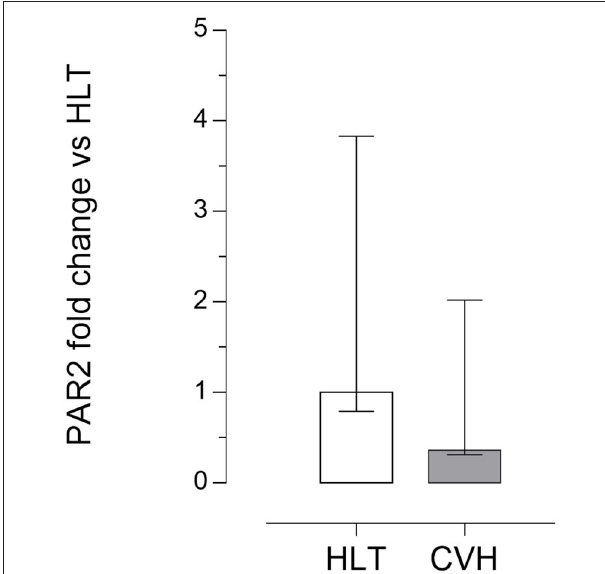
FIGURE 3 | Quantitative Real time PCR for the PAR 2 in the pelvic flexure specimens. The gene expression level of PAR 2 during colon volvulus (CVH group, n = 8) was calculated as fold of change (2 − 11 Ct method) in relation to the colon tracts isolated from the healthy horses (HLT group, n = 8). Data represent the mean ± the range of relative expression of eight biological replicates per group; each experiment was repeated twice. No statistically significant differences in gene expression were observed (student t -test, p < 0.05).